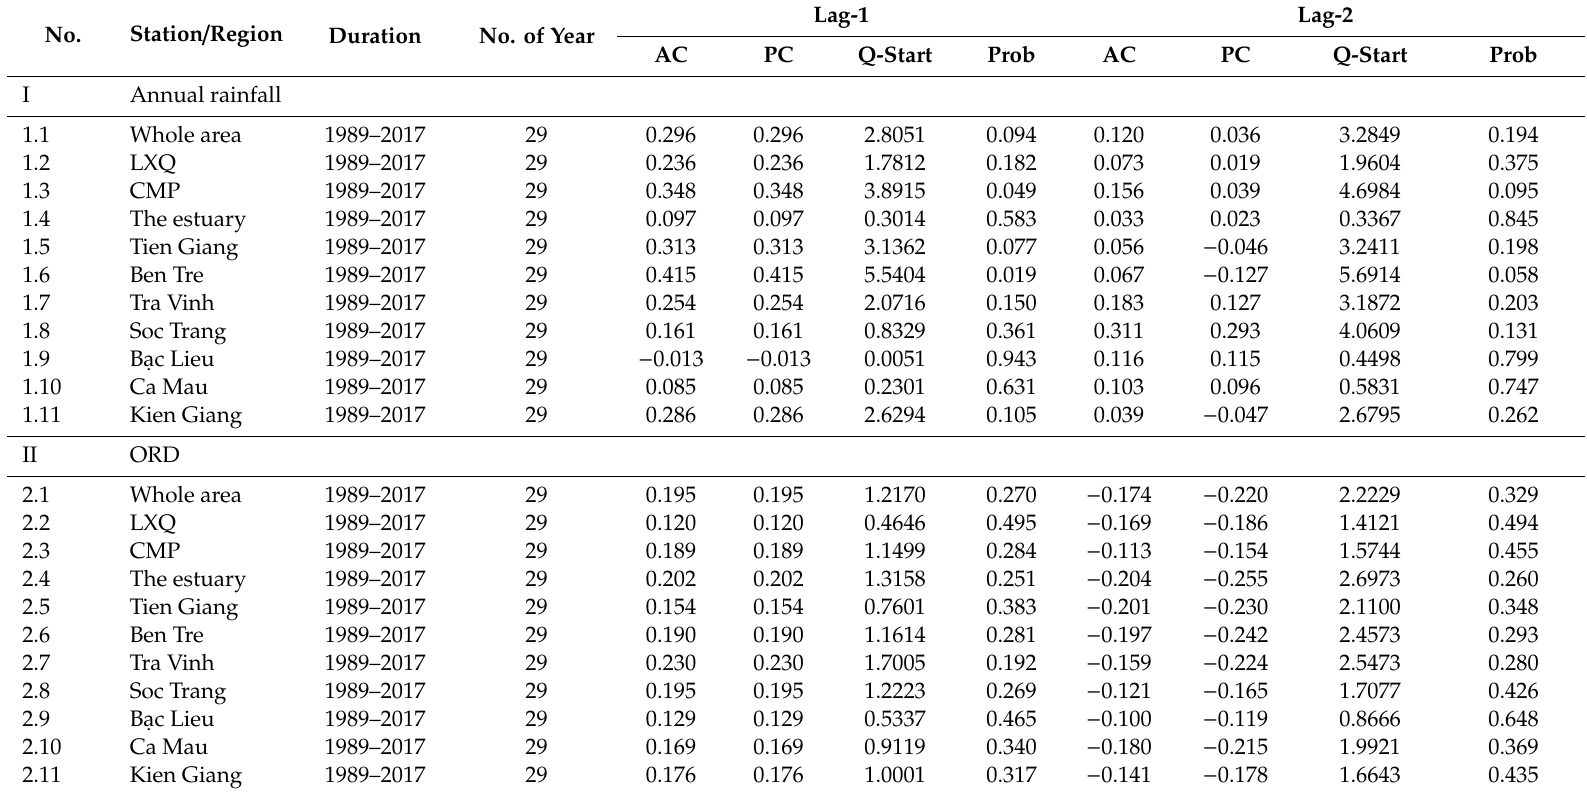
Table A4. Results of autocorrelation analysis for the rainfall